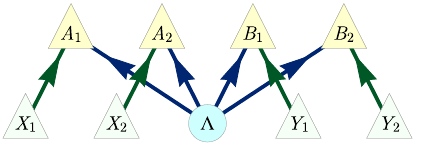
Figure 8: An inflation of the Bell scenario causal structure, where both local settings and outcome variables have been